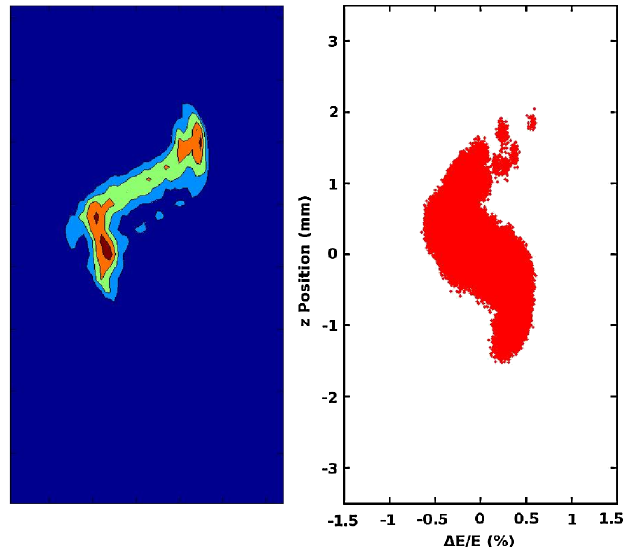
FIG. 3. (Color) Another digitized image, alongside a reconstruc- tion of the phase space for that bunch, including the correction mentioned in Sec. III A. The apparent sign change of the horizontal axis is due to a minus sign in the measured calibration constant.